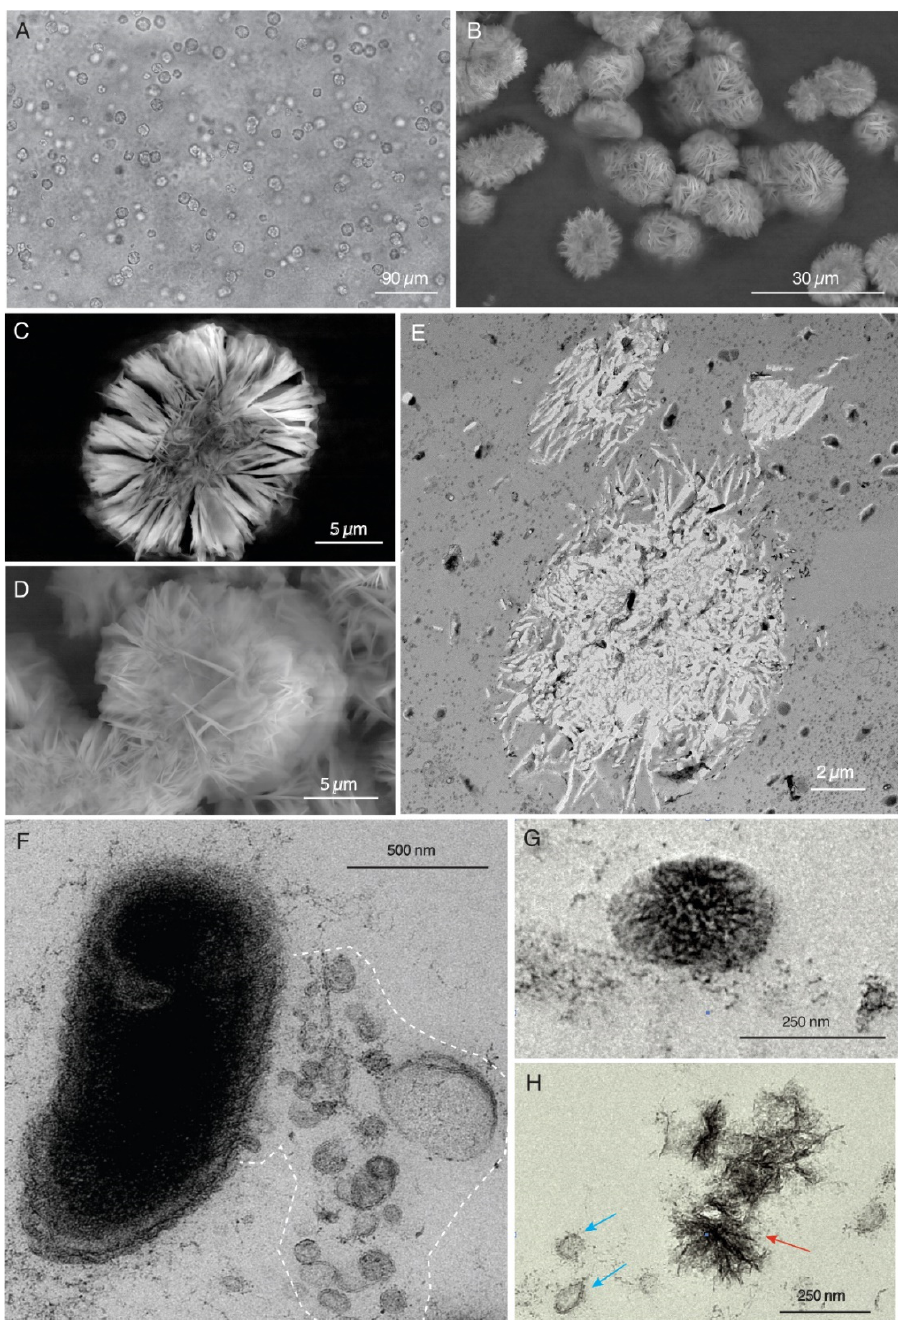
Figure 3. Micrographs of an isolated Mn(II) oxidizing bacterium, Pedobacter sp., and associated Mn precipitates. ( A ) Light-microscopy image showing numerous spherulites constructed of nano- to micro-meter sized sheets. ( B ) SEM image of ( A ). ( C , D ) SEM images of spherulites. ( E ) TEM image of Mn oxide aggregate. ( F ) TEM image of cell releasing vesicles of varying sizes from the outer cell membrane. ( G ) Mn oxides covering a possible vesicle. ( H ) Patches of Mn oxides forming in the mucilaginous colonies (red arrow) and double membrane vesicles (blue arrows).